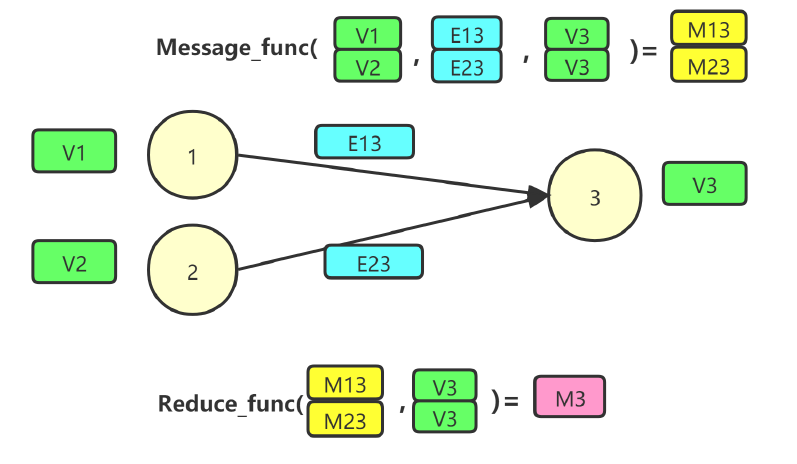
Figure 3. Message Passing of